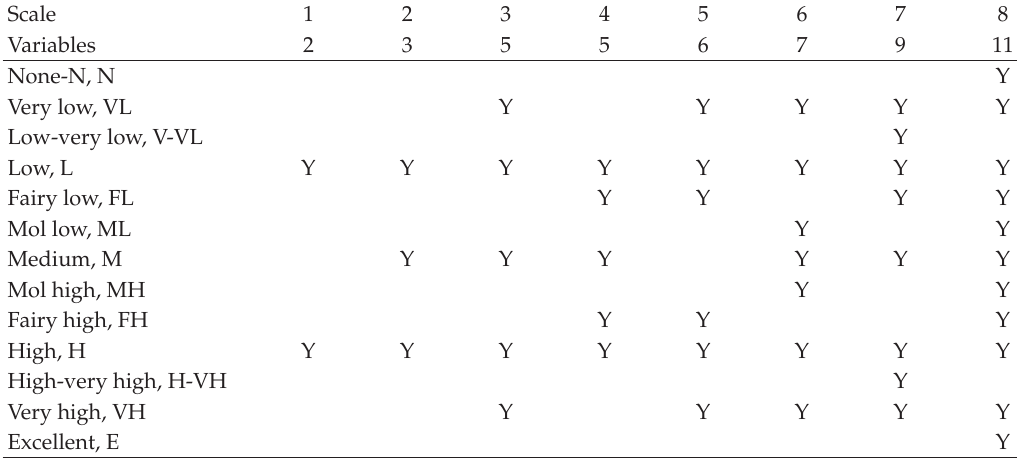
Table 1: Linguistic variable and its